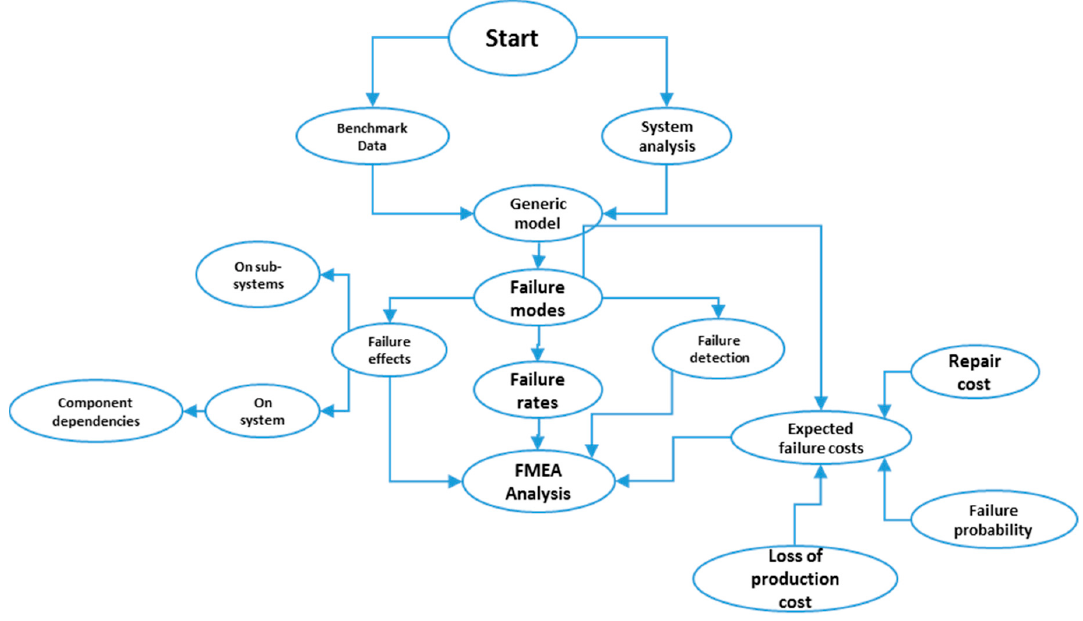
Figure 1. Flowchart representing the hybrid cost-FMEA process followed in this study.